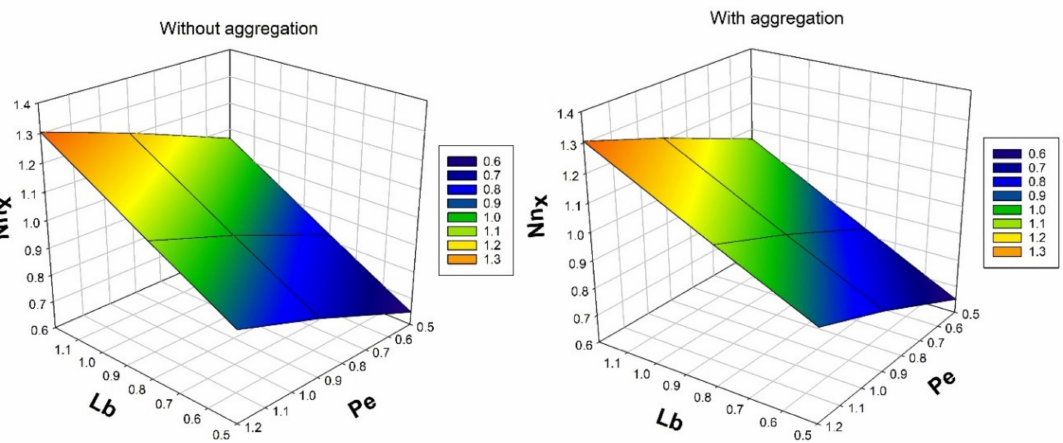
Figure 11. Nature of density number of motile microorganisms ( Nn x ) over bioconvection Peclet number Pe for numerous values of bioconvection Lewis number Lb